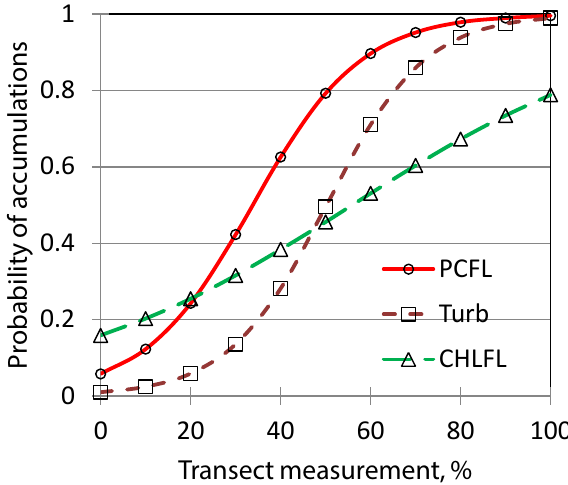
Figure 9. Probability of surface cyanobacteria accumulations esti- mated with the logistic regression as a function of phycocyanin fluo- rescence (PCFL), turbidity (Turb) and Chl a fluorescence (CHLFL) at approximately 5m depth. The values of PCFL, Turb and CHLFL are normalized to a scale from 0–100.